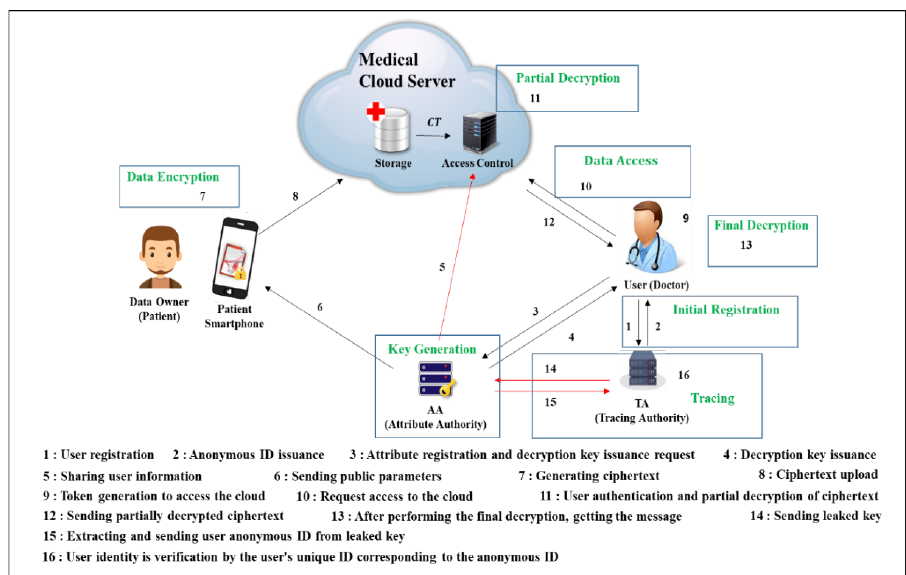
Figure 6. Overall scenario of the proposed scheme.